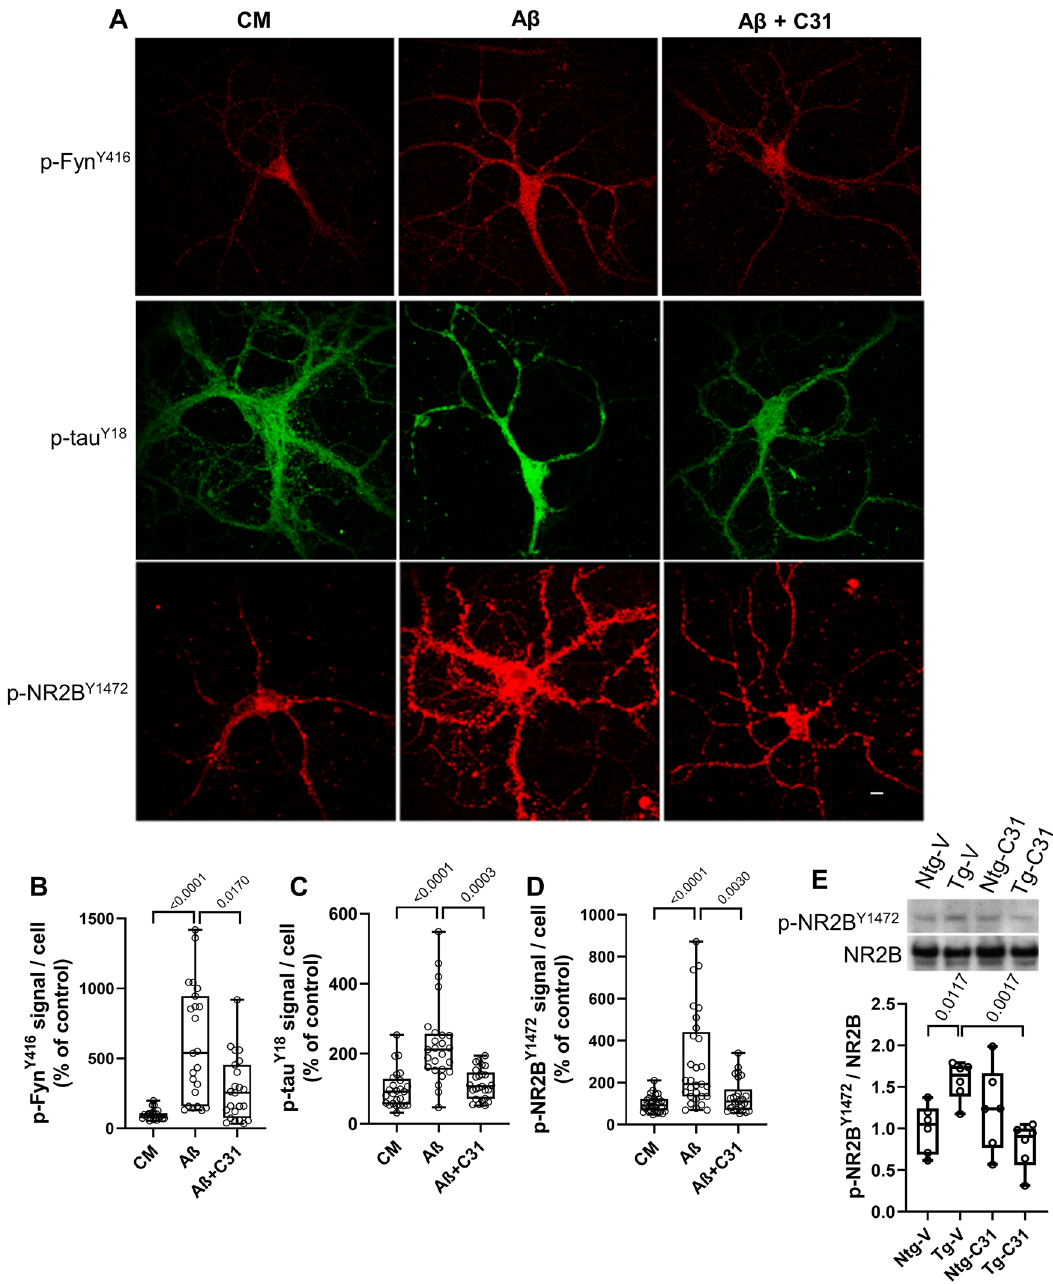
Figure 4. LM11A-31 modulates Aβ-induced Fyn activation and substrate phosphorylation. ( A ) 21 DIV hippocampal neurons were treated with CM or Aβ ± LM11A-31 and fixed and immunostained with the indicated antibodies after 20 min. Scale bar, 10 µm. ( B – D ) Total fluorescence intensity was measured and ratios of total fluorescence intensity to total cell numbers per field were calculated. For p-Fyn Y416 , n = 18–22 fields derived from 4 independent experiments; p-NR2B Y1472 , n = 24 fields derived from 6 independent experiments; p-tau Y18 , n = 30 fields derived from 5 independent experiments. Statistical significance of the indicated comparisons was determined using Kruskal–Wallis ANOVA with post-hoc Dunn’s Multiple Comparisons test. ( E ) 7.5–8.0 months old non-transgenic mice (Ntg) and AβPPL/S mice (Tg) were treated with LM11A-31 by oral gavage for 3 months. RIPA protein extracts from hippocampal tissue were assessed by western blot analysis and the ratio of phospho-NR2B Y1472 to total NR2B protein was determined with normalization to Ntg-V. n = 6 mice per group, with three independent western blots averaged per animal. Statistical significance of the indicated comparisons was determined in ( C , D ) using Kruskal–Wallis ANOVA with post-hoc Dunn’s multiple comparisons test and in ( B , E ) using Regular ANOVA with post-hoc Sidak’s multiple comparison